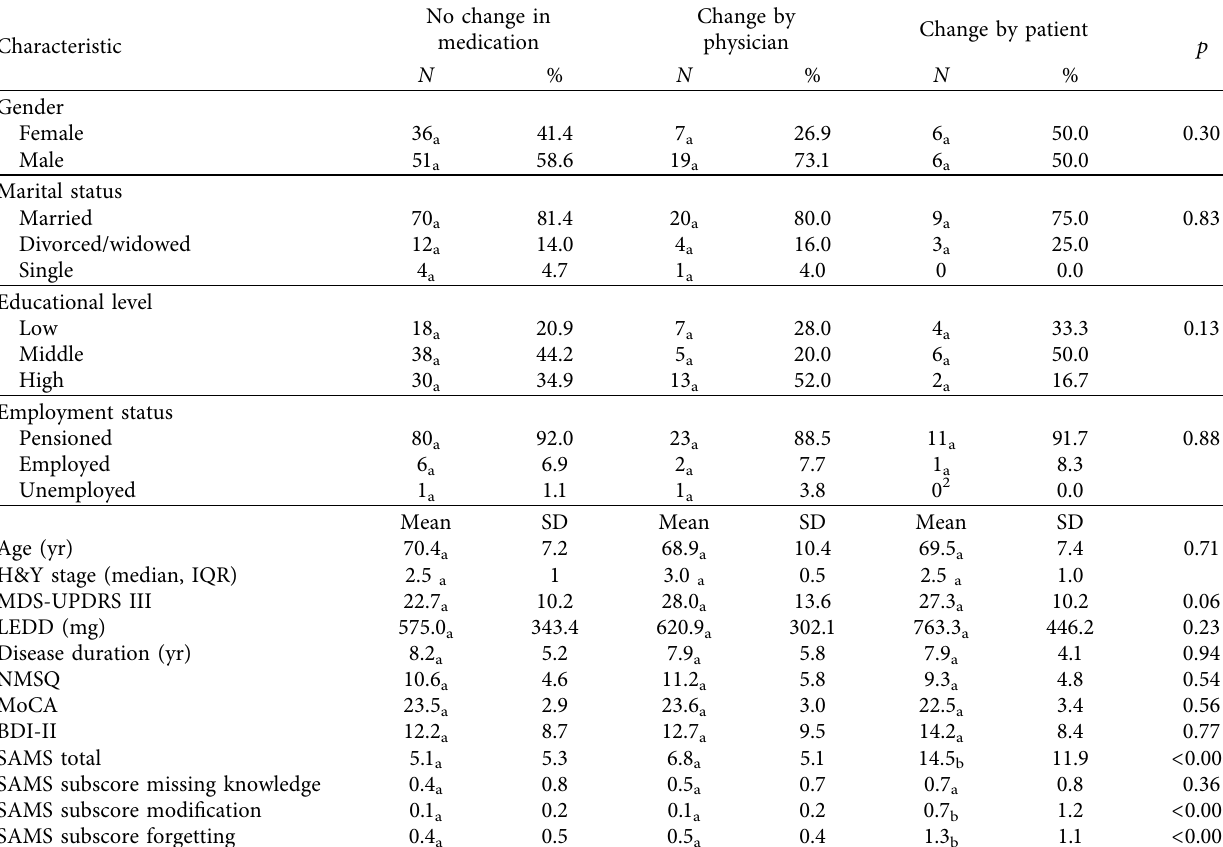
Table 4: Characteristics of patients with and without changes in